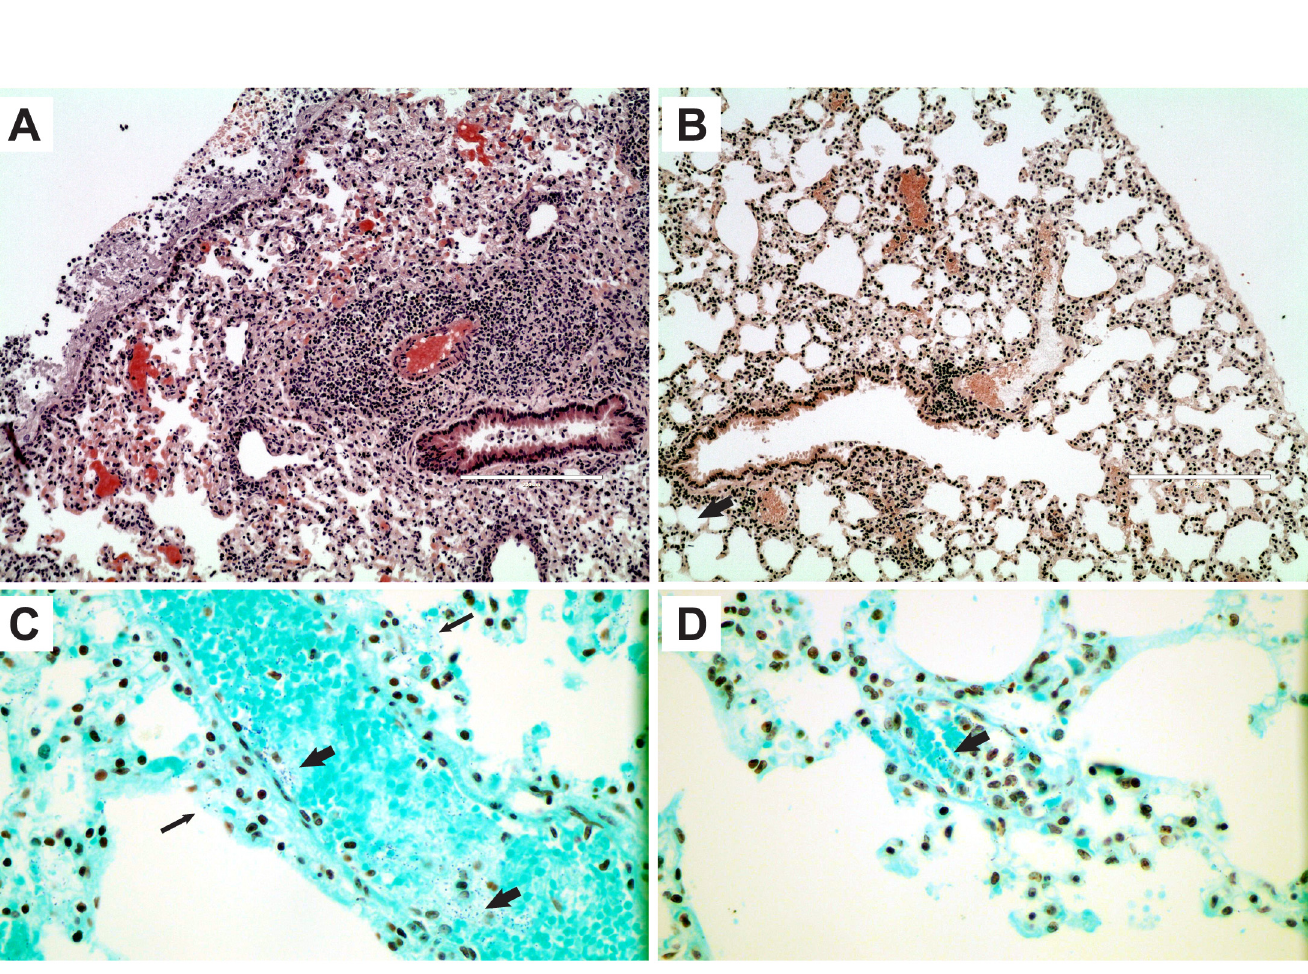
Fig 3. Histopathology and Gram staining of lung tissues in mice that succumb to intranasal pneumococcal infection. H+E staining of lung tissue from control (A) and SCD (B) mice after they succumbed to pneumococcal infection. Gram stain of the same lung tissue in control (C) and SCD (D) mice. Wide arrows point to pneumococci in blood vessels and narrow arrows point to pneumococci colonizing the surface of the lung tissue.